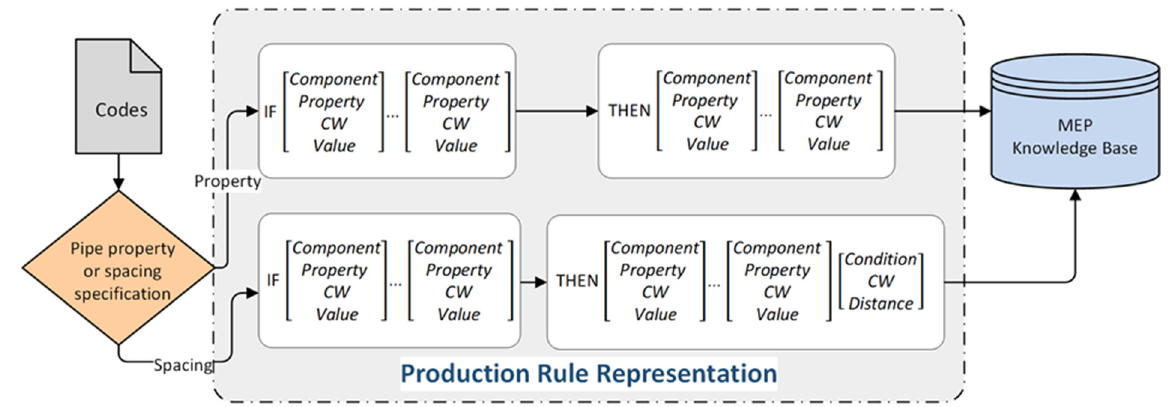
Figure 4. Process of optimizing the MEP knowledge.